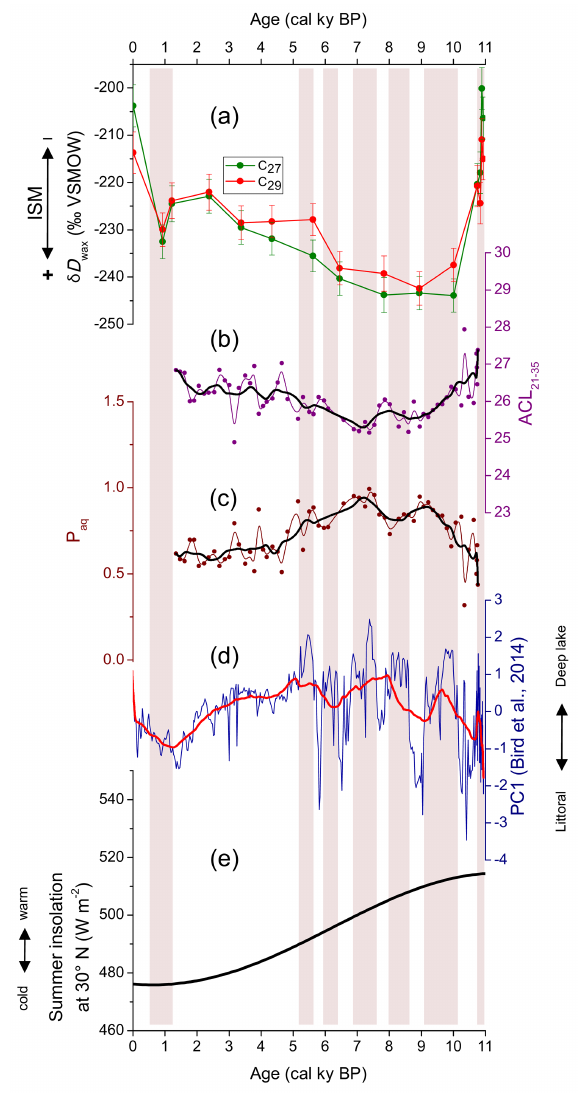
Figure 4. The response of Paru Co aqueous vegetation to changing summer insolation and associated monsoon intensity. (a) δD wax for C 27 and C 29 n -alkanes referenced to Vienna Standard Mean Ocean Water scale, data from Bird et al. (2014). (b) ACL ratio values (purple points), adjacent-average smoothing with 5 points (black), b-spline interpolation (purple line). (c) Paq ratio values (brown points), adjacent-average smoothing with 5 points (black), b-spline interpolation (brown line). (d) Principal component 1 val- ues (blue) as indicative of lake level changes, adjacent-average smoothing with 40 points (red), data from Bird et al. (2014). (e) Summer insolation, data from Berger and Loutre